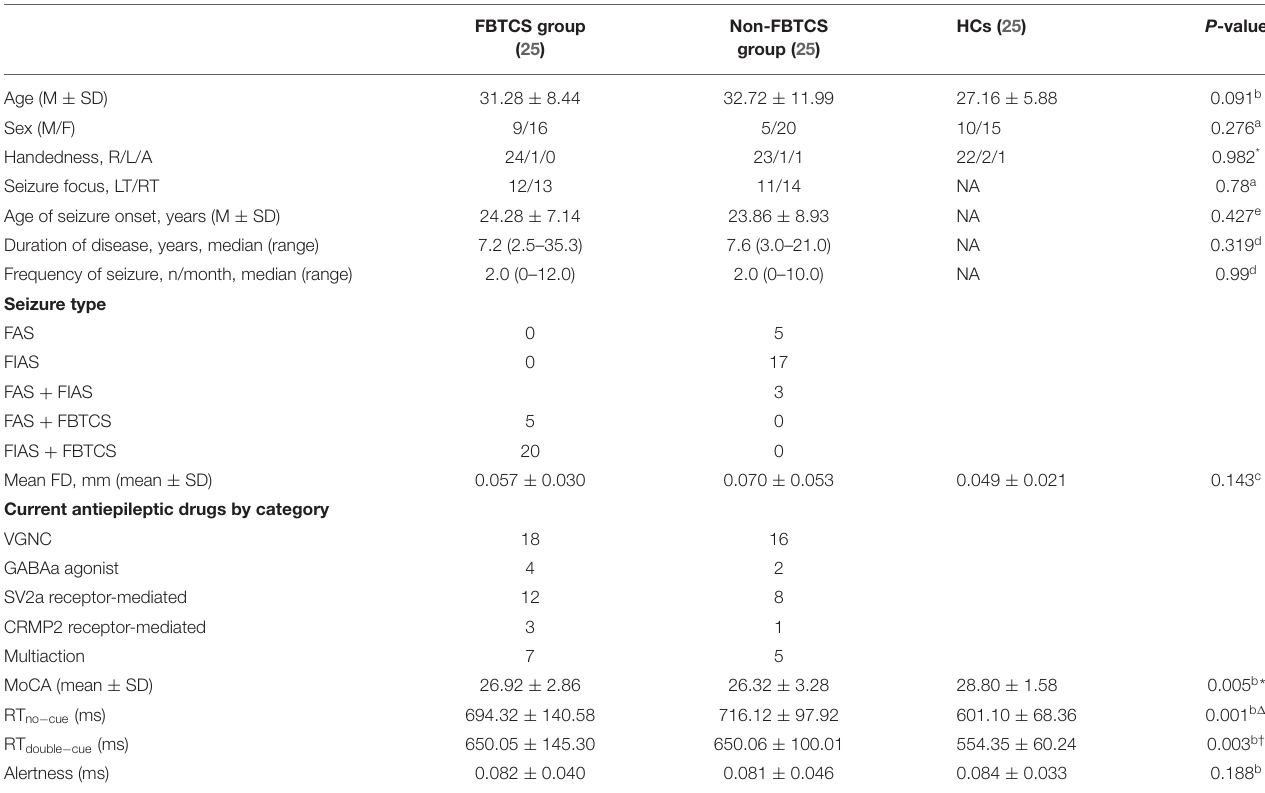
TABLE 1 | The demographic and clinical characteristics of the two TLE groups and